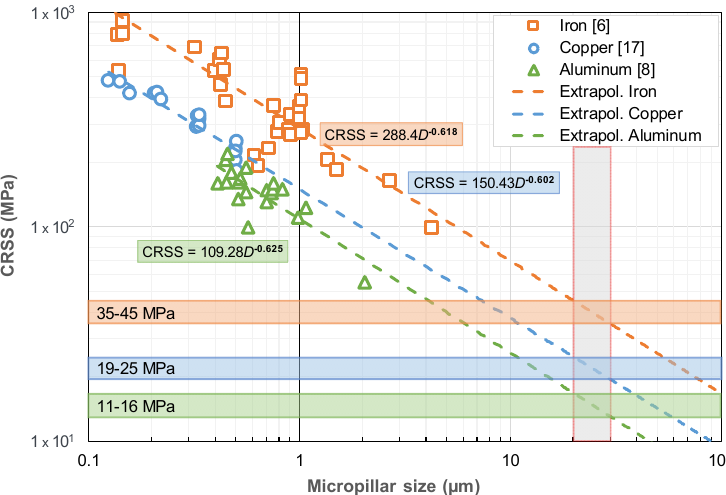
Figure 6. CRSS (critical resolved shear stress) of iron [6], copper [17] and aluminum [8], respectively, as a function of pillar diameter D . Plots of data for different materials show the power law relationship, i.e. the size effect, between pillar diameter and the CRSS, data from [6,8,17]. Table 2. CRSS (critical resolved shear stress) values for different materials.